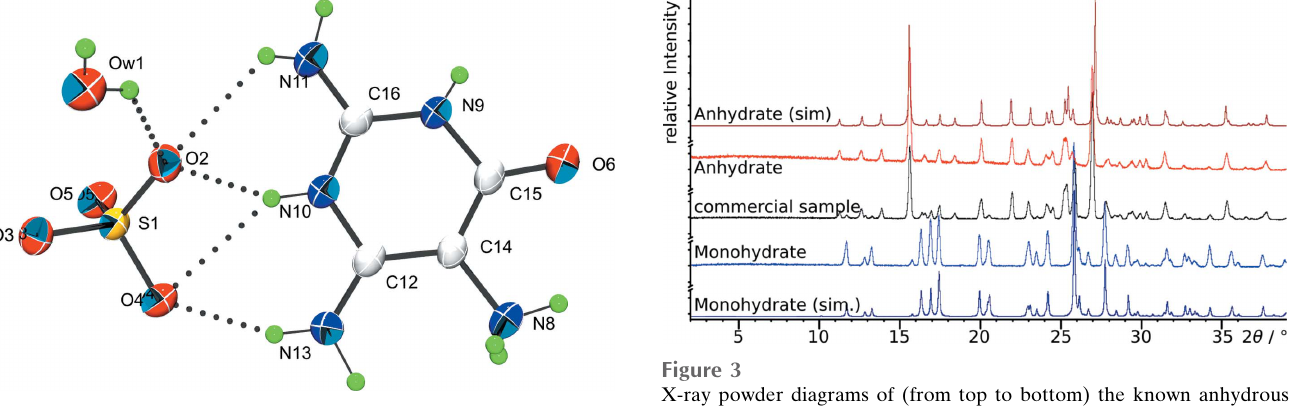
Figure 1 The asymmetric unit of the title compound with displacement ellipsoids drawn at the 50% probability level. Hydrogen bonds are shown as dashed